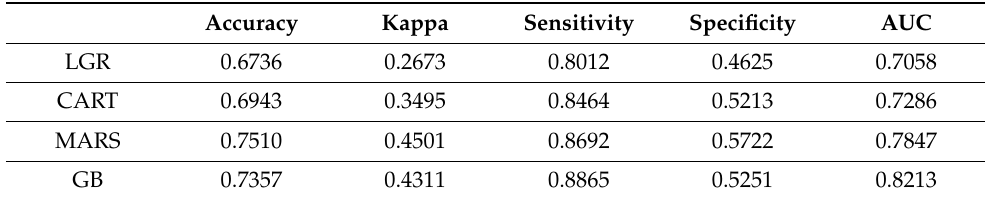
Table 6. Performance evaluation of prediction models.